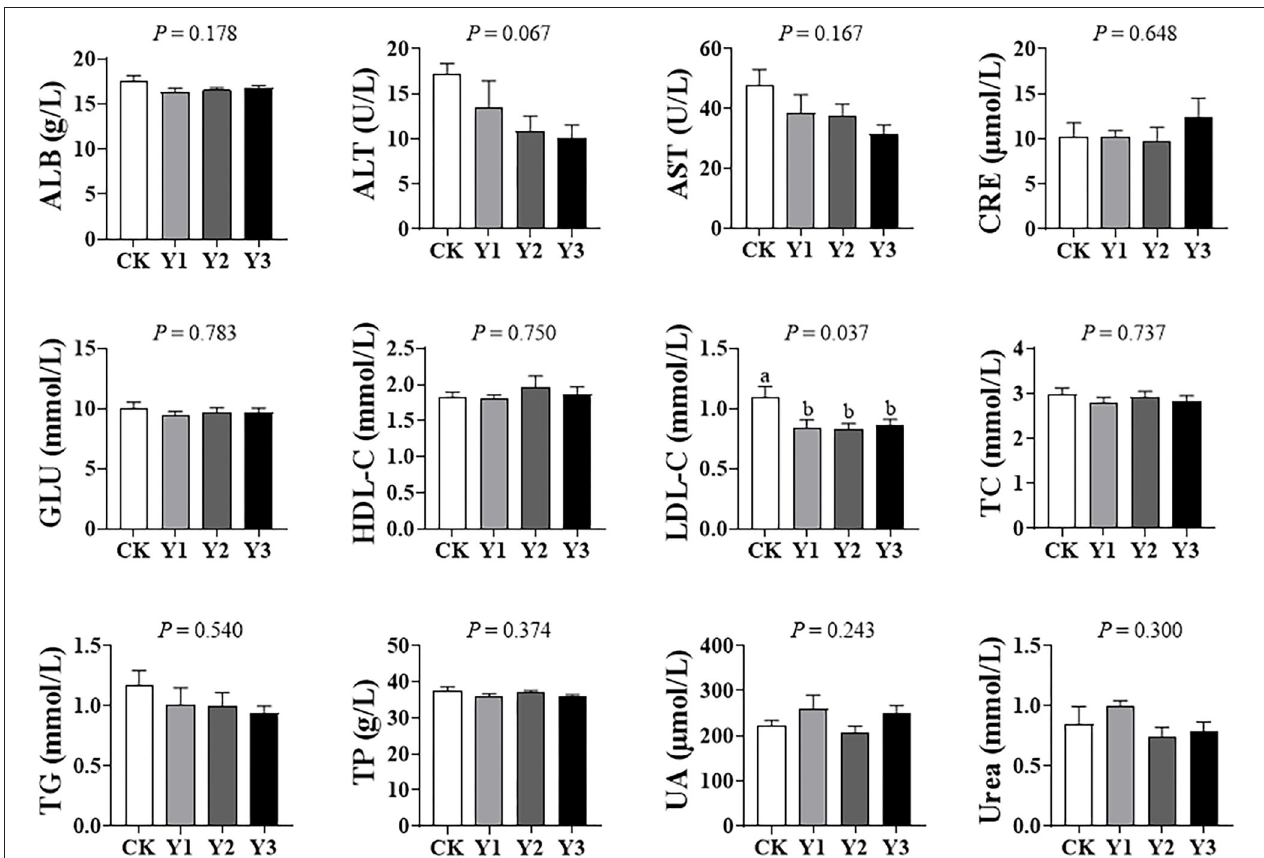
FIGURE 1 | Effects of dietary AOE on serum biochemical parameter in ducks.